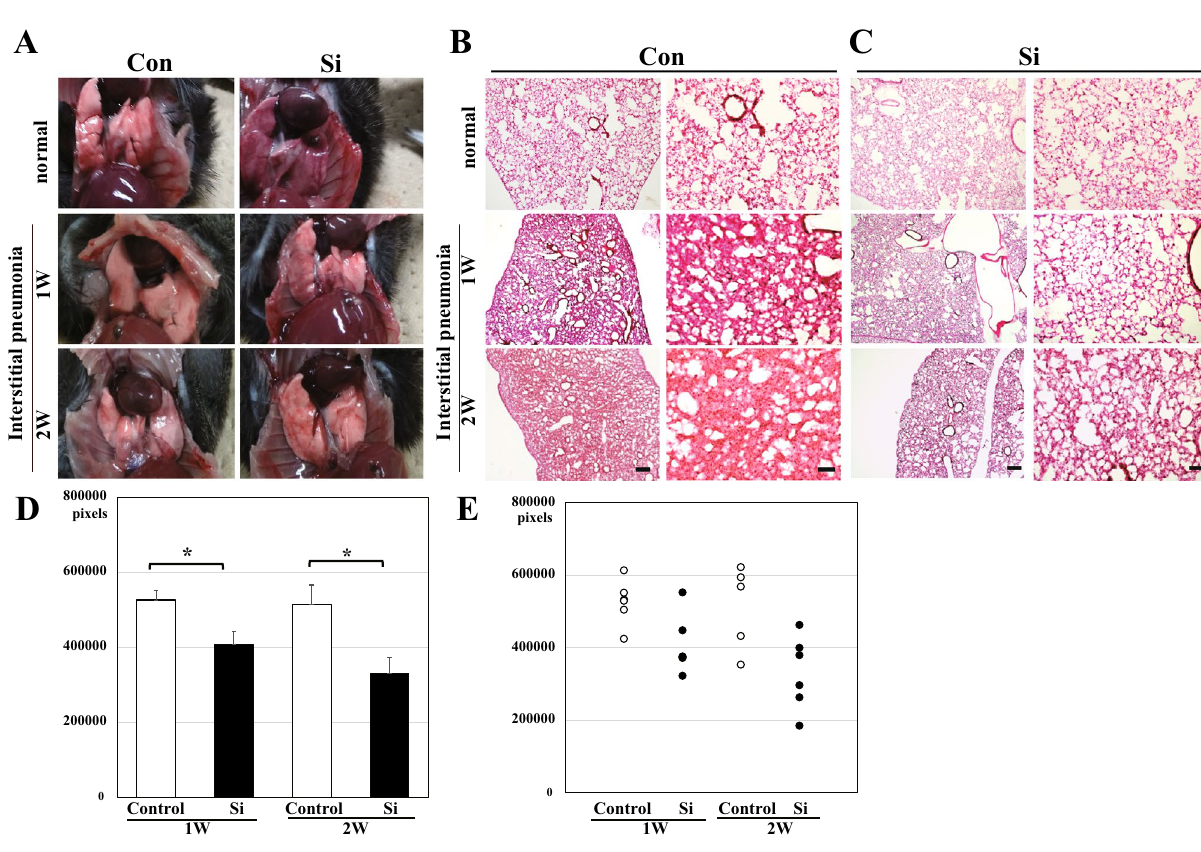
Figure 1. Gross pathology of the lung ( A ) and pathologic analysis using HE-stained lung specimens ( B – E ). ( A ) The representative photographs of the lung in the normal mice (upper panel) and IP mouse models treated with MTX for 1 week (middle panel) and 2 weeks (bottom panel). Left panel: Con group or Con-IP group; right panel: Si group or Si-IP group. ( B , C ) The representative microphotographs of the HE-stained lung in the normal mice (upper panel) and IP mouse models treated with MTX for 1 week (middle panel) and 2 weeks (bottom panel). ( B ) Con group or Con-IP group ( C ) Si group or Si-IP group. Left panel: low magnification; right panel: high magnification. Scale bar 200 µm ( B , C : left); 100 µm ( B , C : right). ( D , E ) The measured results of interstitial area in the lung. ( D ) Bar chart indicates the mean values. ( E ) The dot graph indicates the individual values. White: Control group. Black: Si-based agent group. MTX administration for 1 week (left pair graph) and 2 weeks (right pair graph). Data are expressed as mean. SEM of eight mice per group. ** p < 0.01 vs. Control group, determined by Student’s paired t